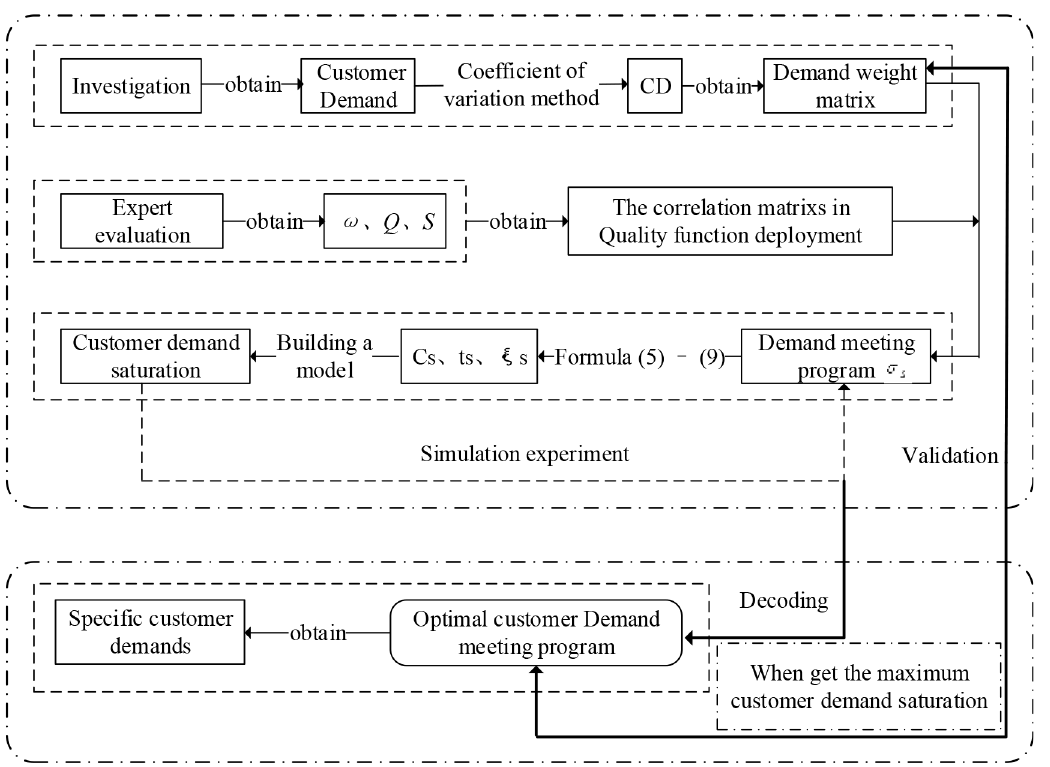
Figure 4. Product development decision optimization flowchart